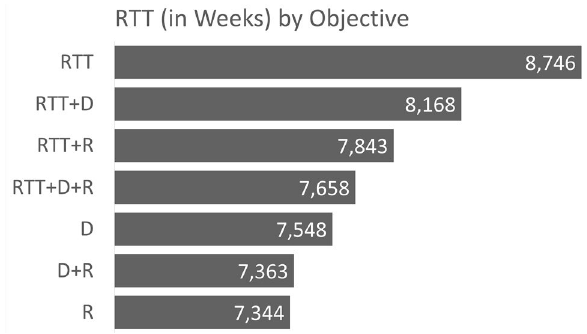
Figure 1. Bar chart representing the RTT measure broken down by models.